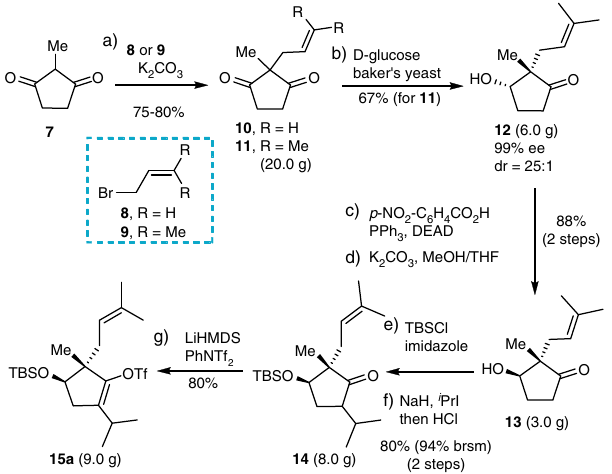
Fig. 3 Synthesis of 15a . Reagents and conditions: (a) 8 or 9 (2.0 equiv), K 2 CO 3 (1.5 equiv), acetone, rt, overnight (75 − 80%); (b) Yeast extract (50 wt%), D -glucose, dry active baker ’ s yeast, H 2 O, rt, 36 h (67%); (c) p -NO 2 -C 6 H 4 CO 2 H (2.0 equiv), PPh 3 (2.0 equiv), DEAD (2.0 equiv), THF, 0 to 50 °C, overnight (90%); (d) K 2 CO 3 (2.0 equiv), MeOH/THF (v/v = 1:2), 0 o C, 30 min (98%); (e) TBSCl (1.2 equiv), imidazole (1.2 equiv), DMF, rt, overnight (91%); (f) NaH (5.0 equiv), i PrI (10.0 equiv), THF, re fl ux, overnight; then aq. HCl (2 M), rt, 1.5 h (88%); (g) LiHMDS (1.3 equiv, 1.0 M in THF), PhNTf 2 (1.3 equiv), THF, − 78 o C to rt, 3 h (80%). DEAD diethyl